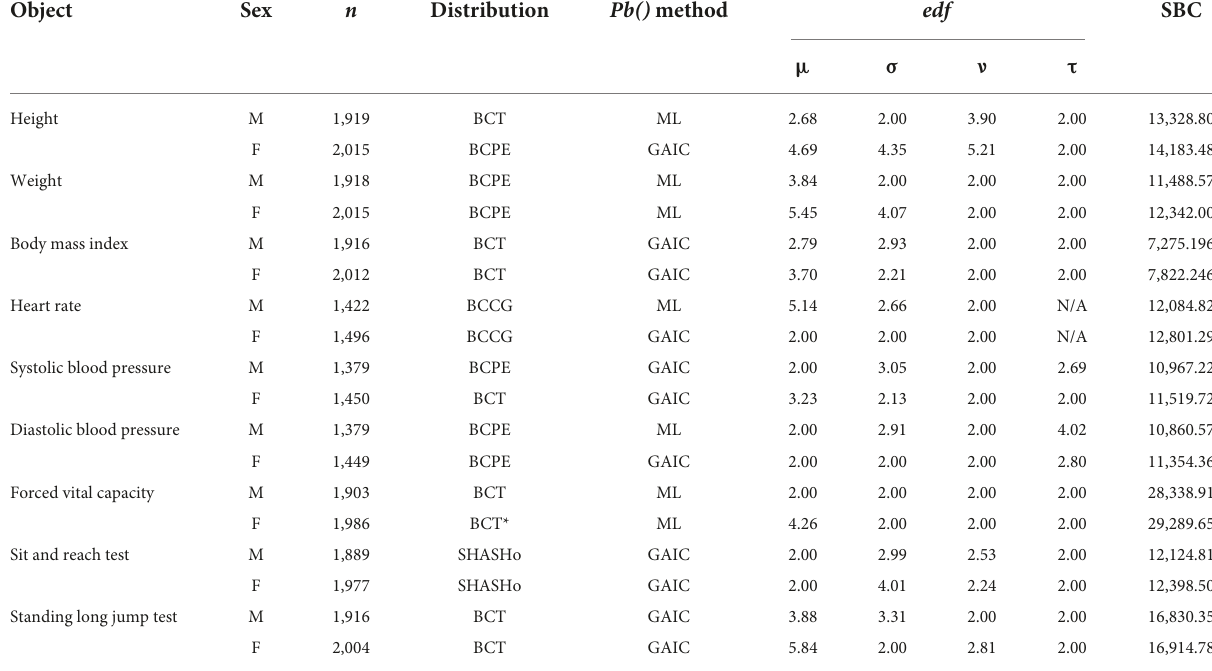
TABLE 4 Summary of fitted GAMLSS model